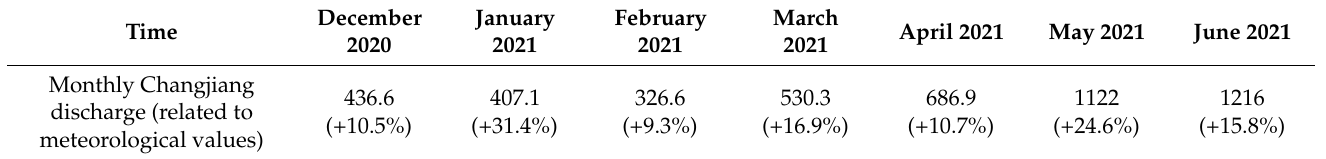
Table 2. Changjiang discharges (10 8 m 3